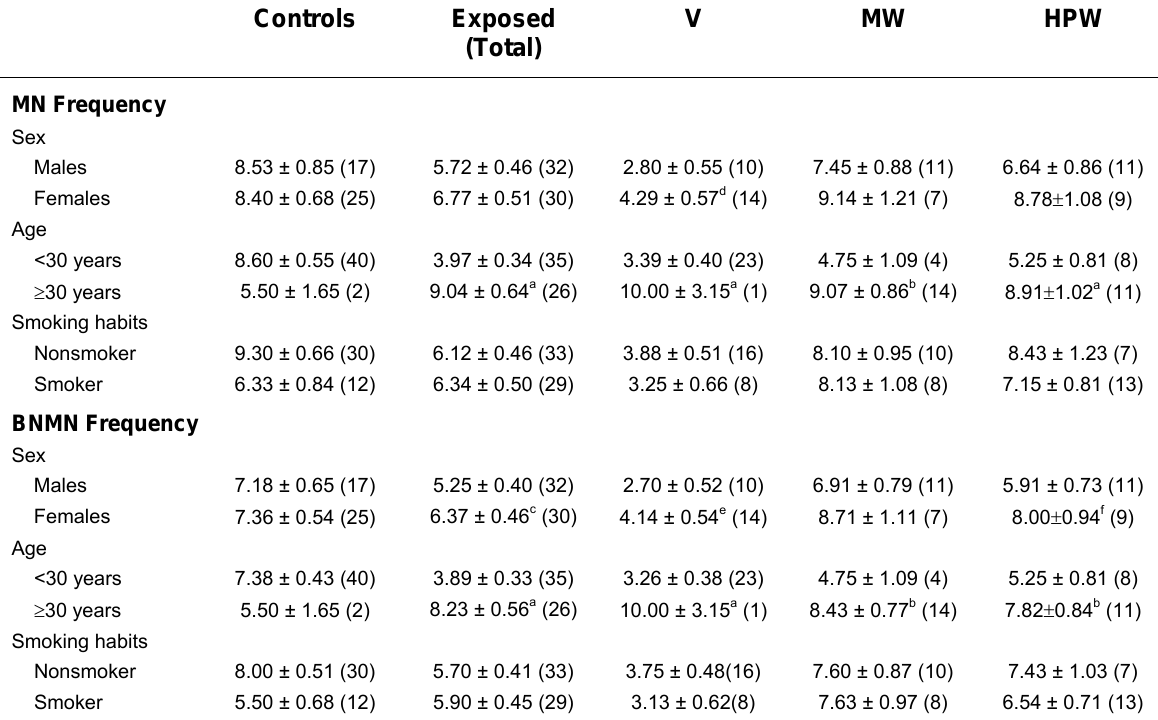
Influence of Sex, Age, and Smoking Habits on MN and BNMN Frequency (mean ± SE)